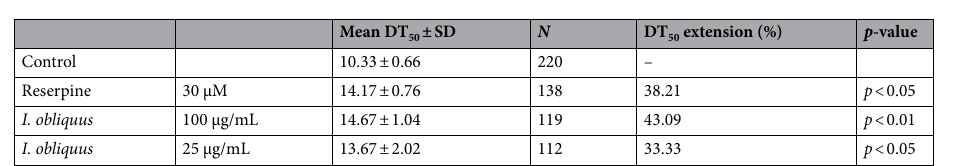
Table 2. Survival analysis upon treatment with I. obliquus. N is the total number of worms assayed for survival. One way ANOVA with Dunnett’s post-test was used for statistical evaluation. P -value < 0.05 was considered as statistically